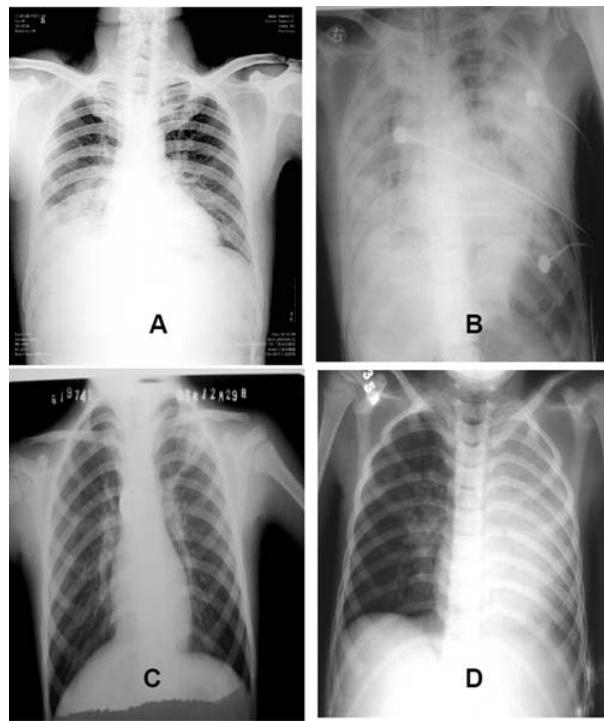
Figure 1. Progression of pulmonary disease in chest radio- graphs from adult (35-year-old male, Panels A day 6 and B day 23 of illness) and pediatric (6-year-old male, Panels C day 6 and D day 14 of illness) H5N1